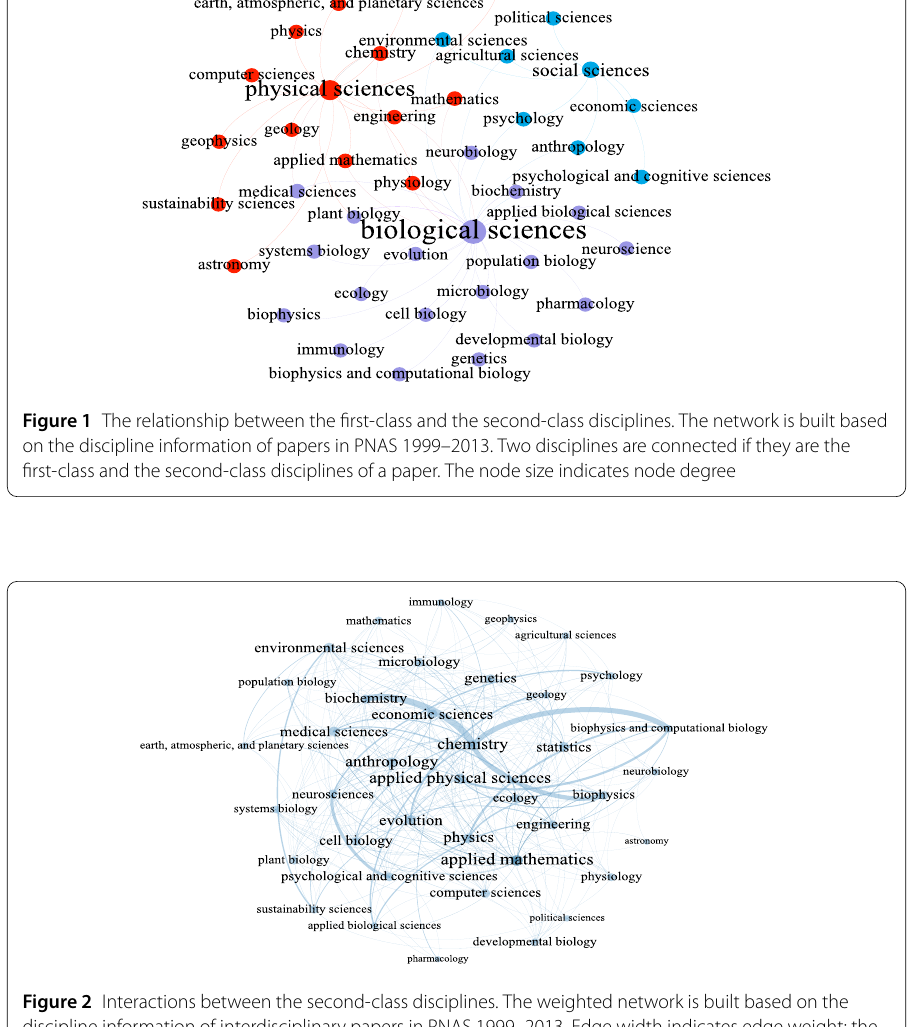
Figure 2 Interactions between the second-class disciplines. The weighted network is built based on the discipline information of interdisciplinary papers in PNAS 1999–2013. Edge width indicates edge weight: the number of interdisciplinary papers between two connected disciplines